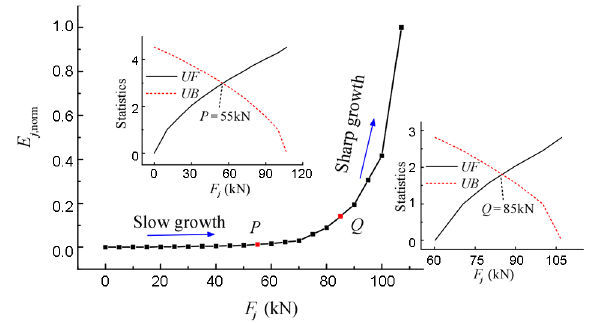
Figure 3. The E j ,norm - F j curve of arch D and the characteristic points P and Q